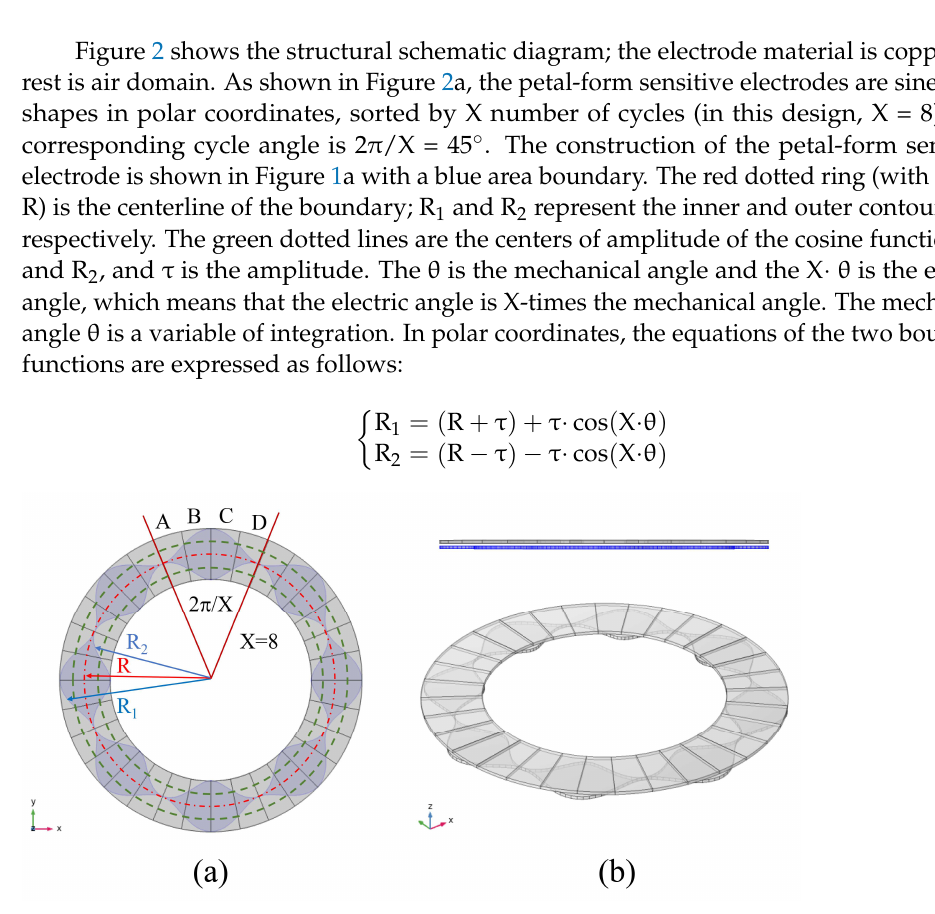
Figure 1. Structure of the capacitor angle sensor: ( a ) petal-shaped rotor and ( b ) fan-shaped stator.